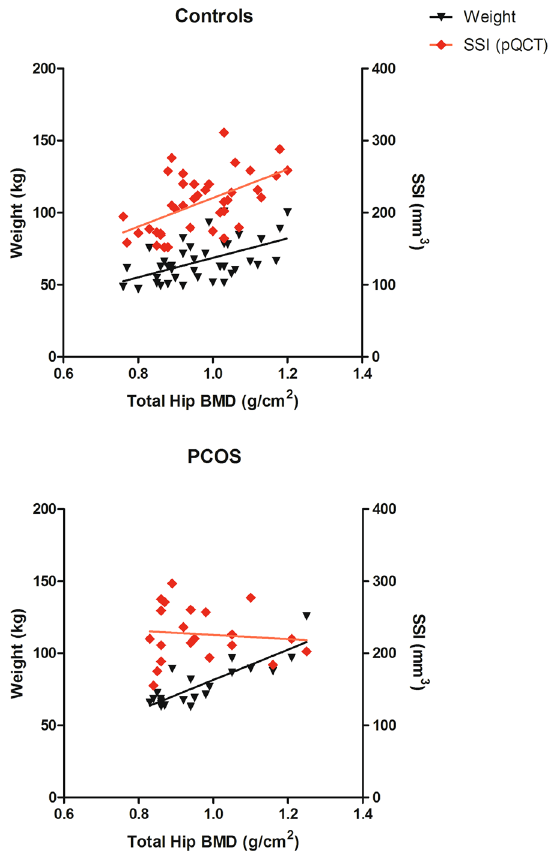
Figure 1. Linear regression of the total hip BMD (g/cm 2 ) with weight (kg) and the radial strength-strain index (SSI, mm 3 ) as the independent variables for women with PCOS (n = 21) and controls without PCOS (n = 39). Weight was a significant predictor of the total hip BMD, R 2 = 0.72, p < 0.0001 for women with PCOS; R 2 = 0.29, p < 0.001 for controls. The radial SSI was not a significant predictor of the total hip BMD for the women with PCOS, R 2 = 0.01, p = 0.68, but was important in the controls, R 2 = 0.30, p <